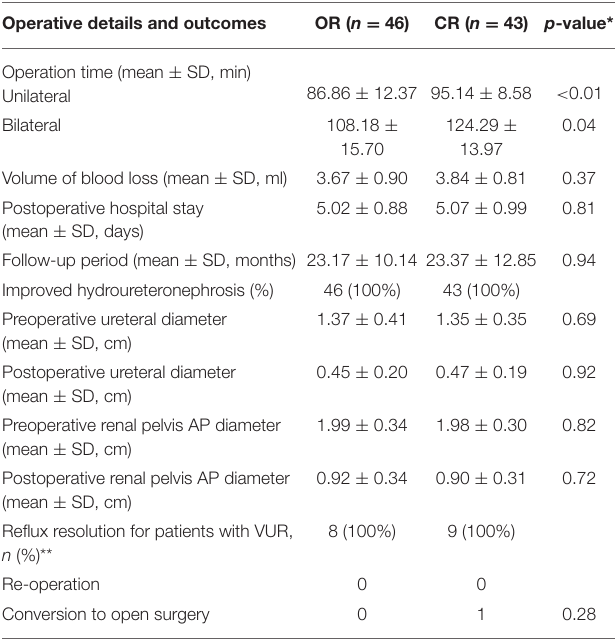
* p-values calculated using the chi-squared test for categorical variables and Student’s t-test for continuous variables. ** Reflux resolution in patients with VUR in the two groups;